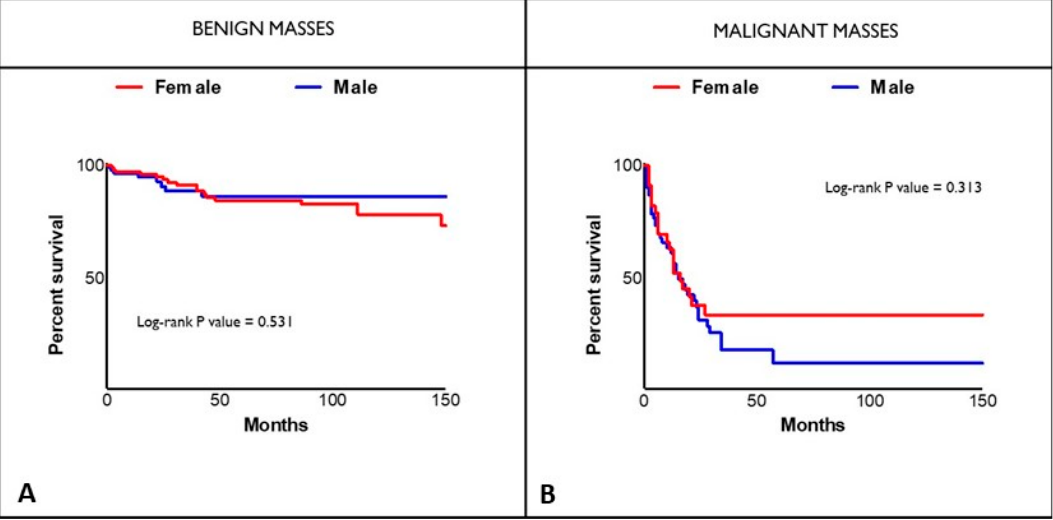
Figure 1. Kaplan-Meier Survival Curves. ( A ) Survival in patients with benign neoformations according to gender. ( B ) Survival in patients with malignant tumours according to gender. Table 5. Mortality during follow up among histology subgroups according to sex. Total Population